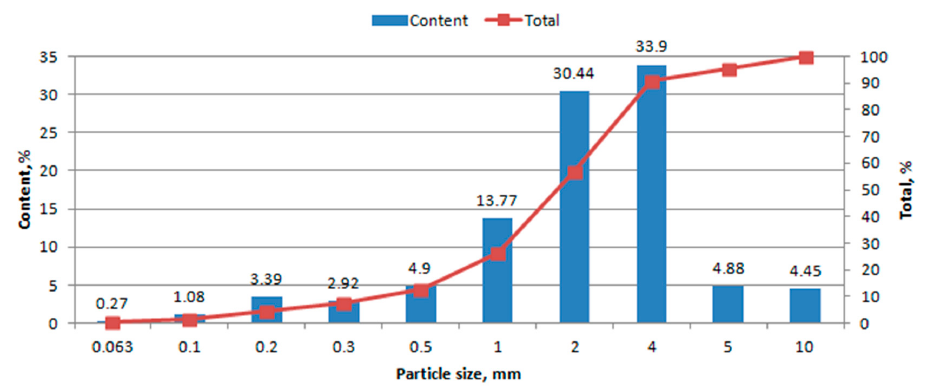
Figure 3. The grain size distribution in PETWW.